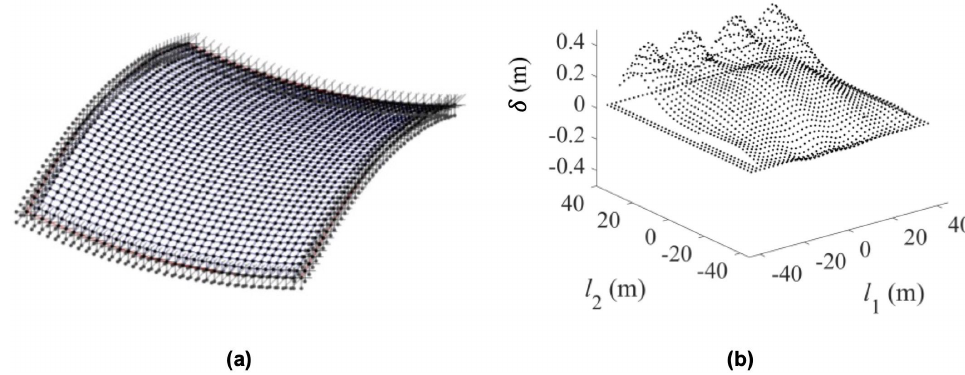
Figure 21: Cable net FEM analyses: FEM model (a), vertical displacements by using experimental mean pressure coeflcients (b)